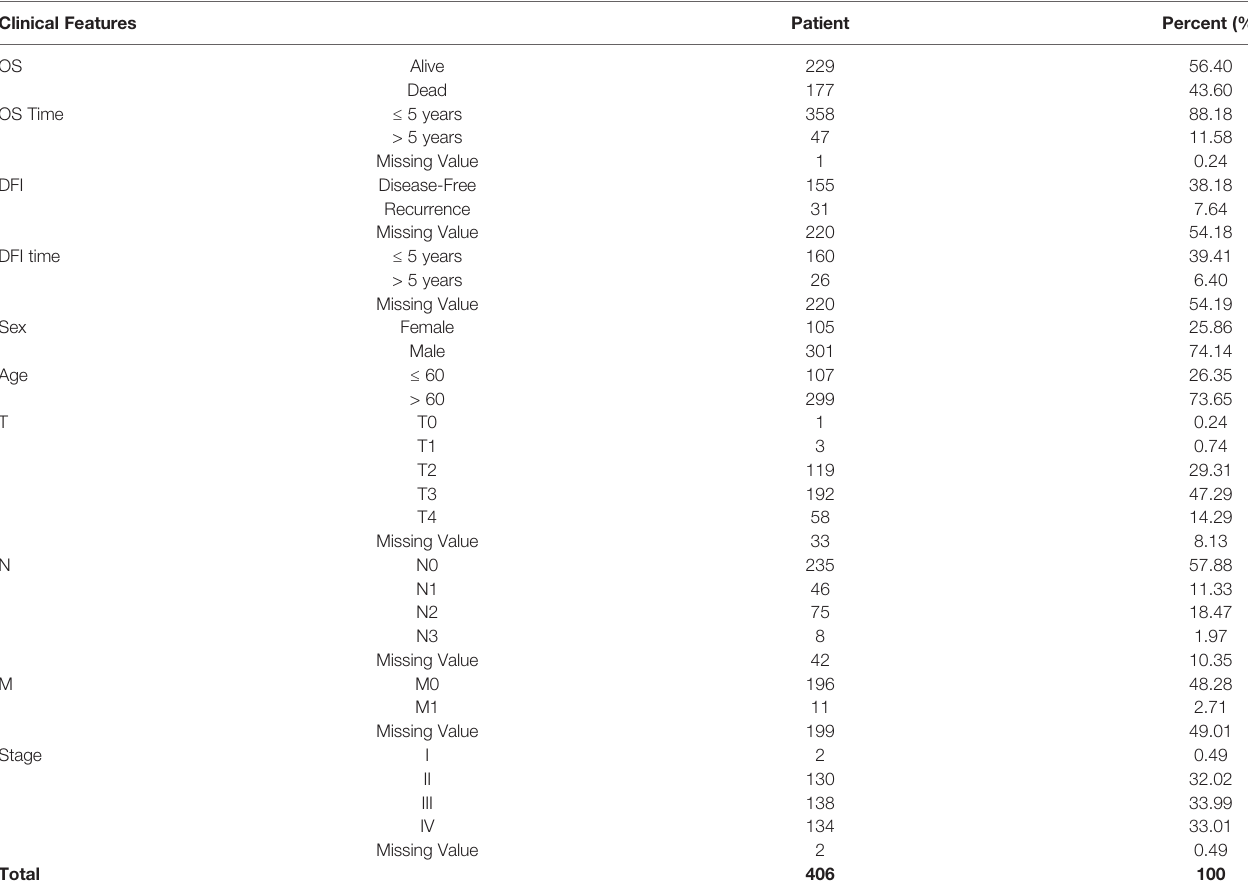
TABLE 1 | Clinical features of bladder urothelial carcinoma. Clinical